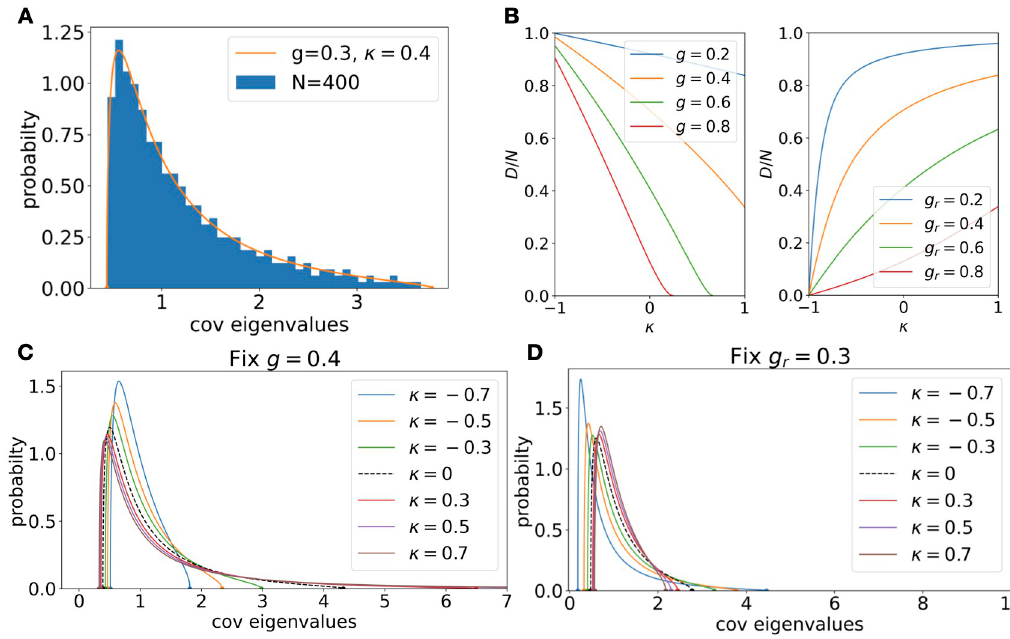
Fig 4. Impact of reciprocal motifs. A . Compare theoretical covariance spectrum for random connectivity with reciprocal motifs and a finite-size network covariance using Eq (2)( g = 0.4, κ = 0.4, N = 400). B . The impact of reciprocal motifs on dimension for various g = g / g (Eq (18)). For small g , the dimension increases sharply with κ . C . The spectra at various κ while fixing g = 0.4. r c r The black dashed line is the i.i.d. random connectivity ( κ = 0). D . Same as C. but fixing relative g r = 0.4 to control the main effect (see text). The changes in shape are now smaller and the support narrows with increasing κ